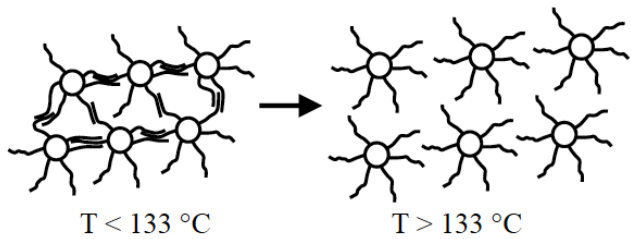
Figure 18. Schematic representation of the crystallization by interdigitation